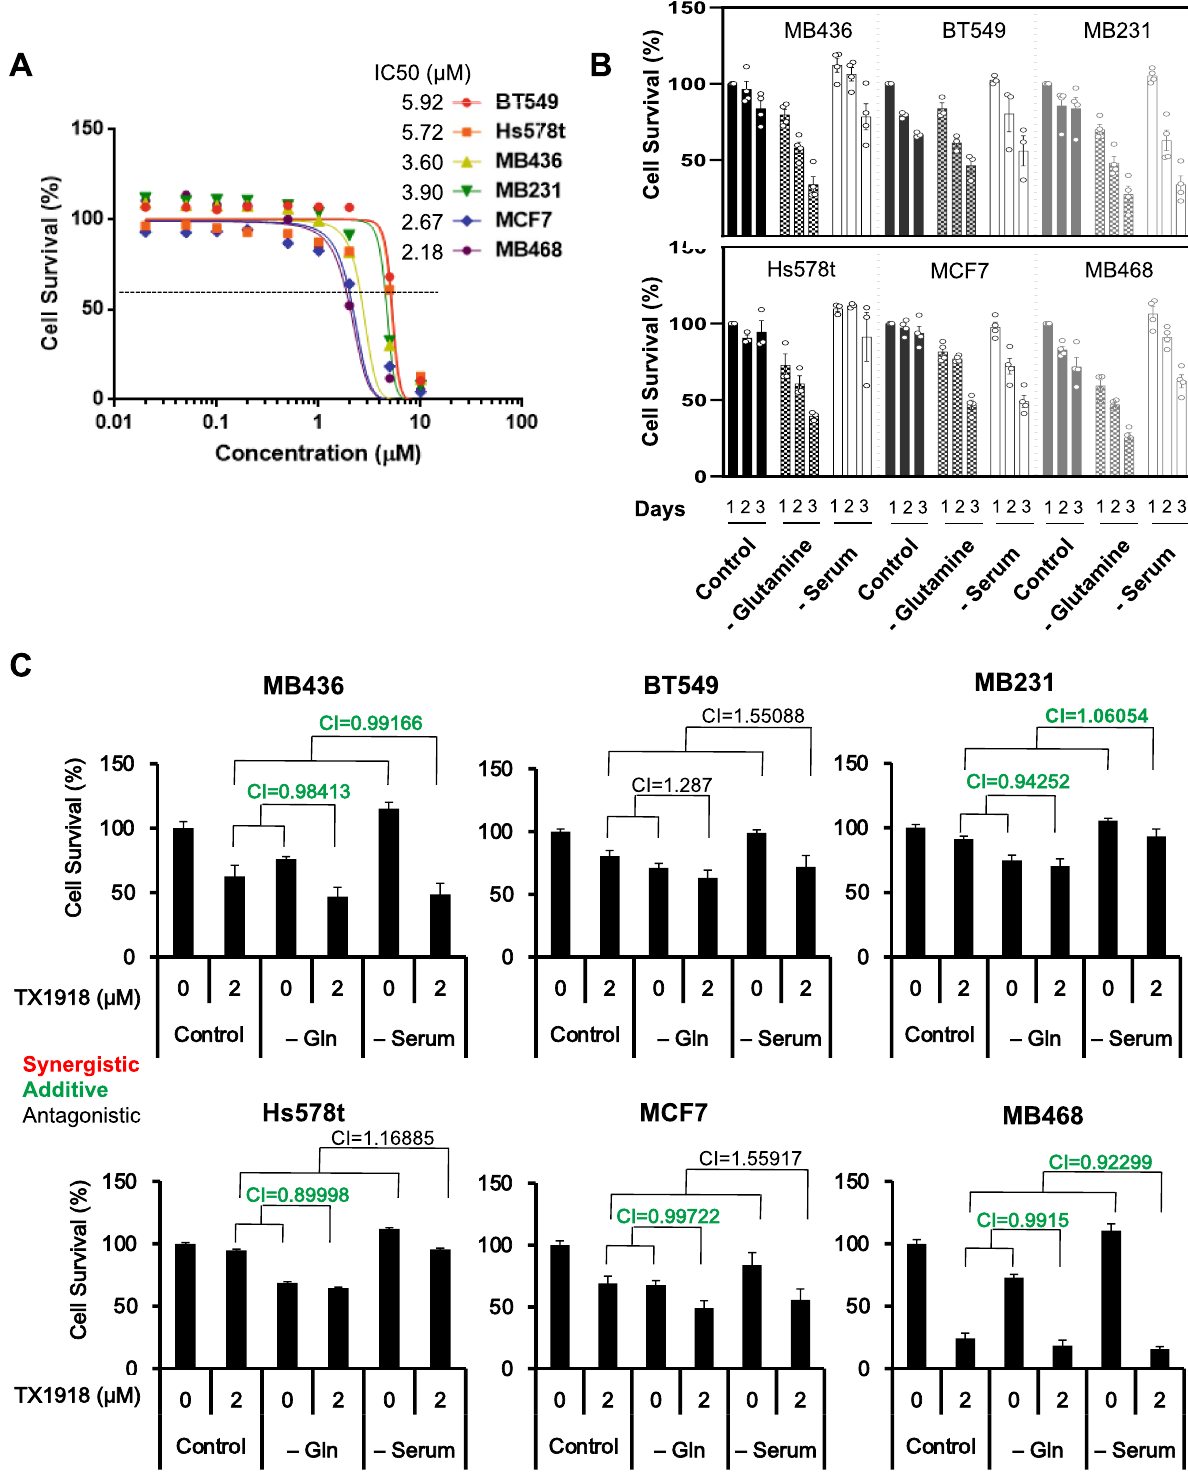
Figure 1. Pharmacological inhibition of eEF2K suppresses growth of breast cancer cell lines under nutrient deprivation (ND). ( A ) Dose response curves for the eEF2K inhibitor TX1918 of indicated breast cancer cell lines using MTT assays. IC50 for each line is indicated (see Supplementary Fig. S1A for details). ( B ) Time-dependent response of indicated breast cancer cell lines to TX1918 (0 or 2 µM) in normal medium (control), without serum or without glutamine (Gln). Numbers in brackets denote incubation periods in days. ( C ) Synergistic effects of TX1918 under serum or Gln deprivation, determined by CompuSyn analysis. Combination Index: CI < 0.85 denotes synergy (red), 0.85 < CI < 1.1, additive (Green), and CI > 1.1, antagonistic effect